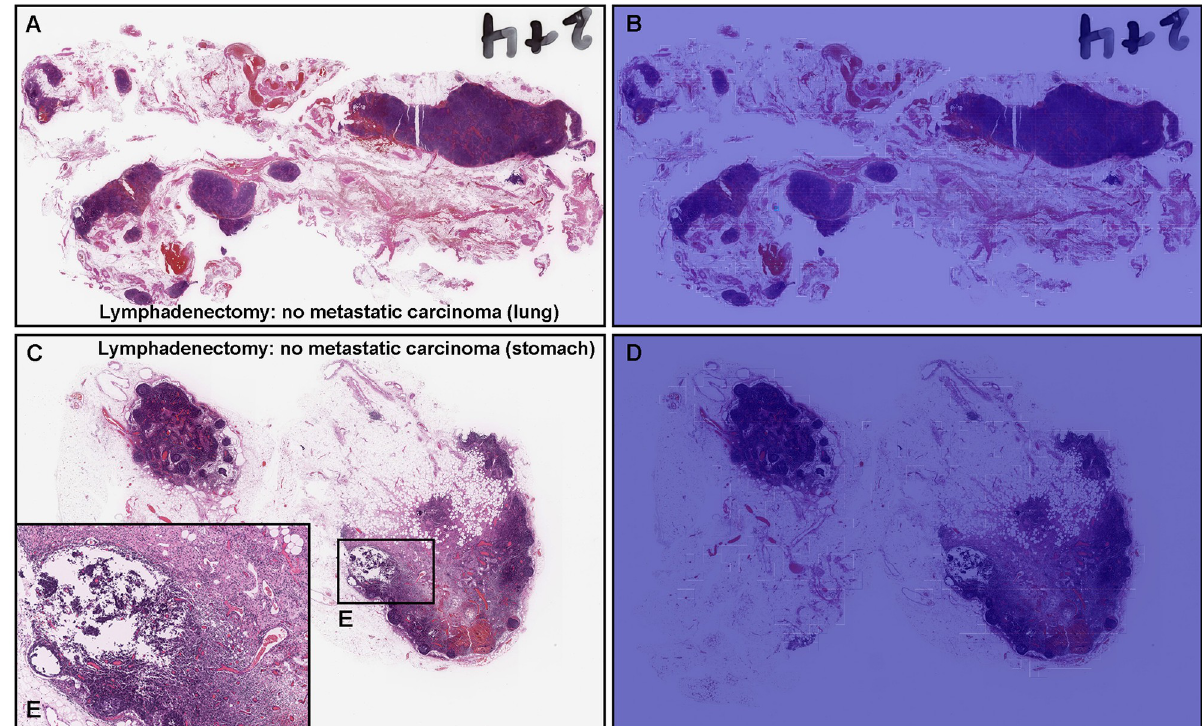
Fig 5. Representative true negative metastatic adenocarcinoma classification of radical lymph node dissection (lymphadenectomy) test sets using the model (WS-4K: 224, x10 EfficientNetB1). Histopathologically, in (A), there were diverse size (small to large) and shape (round to irregular) of lymph nodes without evidence of metastatic adenocarcinoma. The heatmap image (B) shows true negative prediction of metastatic adenocarcinoma. Histopathologically, in (C), there were lymph nodes with lymphadenitis (E) but without evidence of metastatic adenocarcinoma (C, E). The heatmap image (D) shows true negative prediction of metastatic adenocarcinoma. The heatmap uses the jet color map where blue indicates low probability and red indicates high probability.